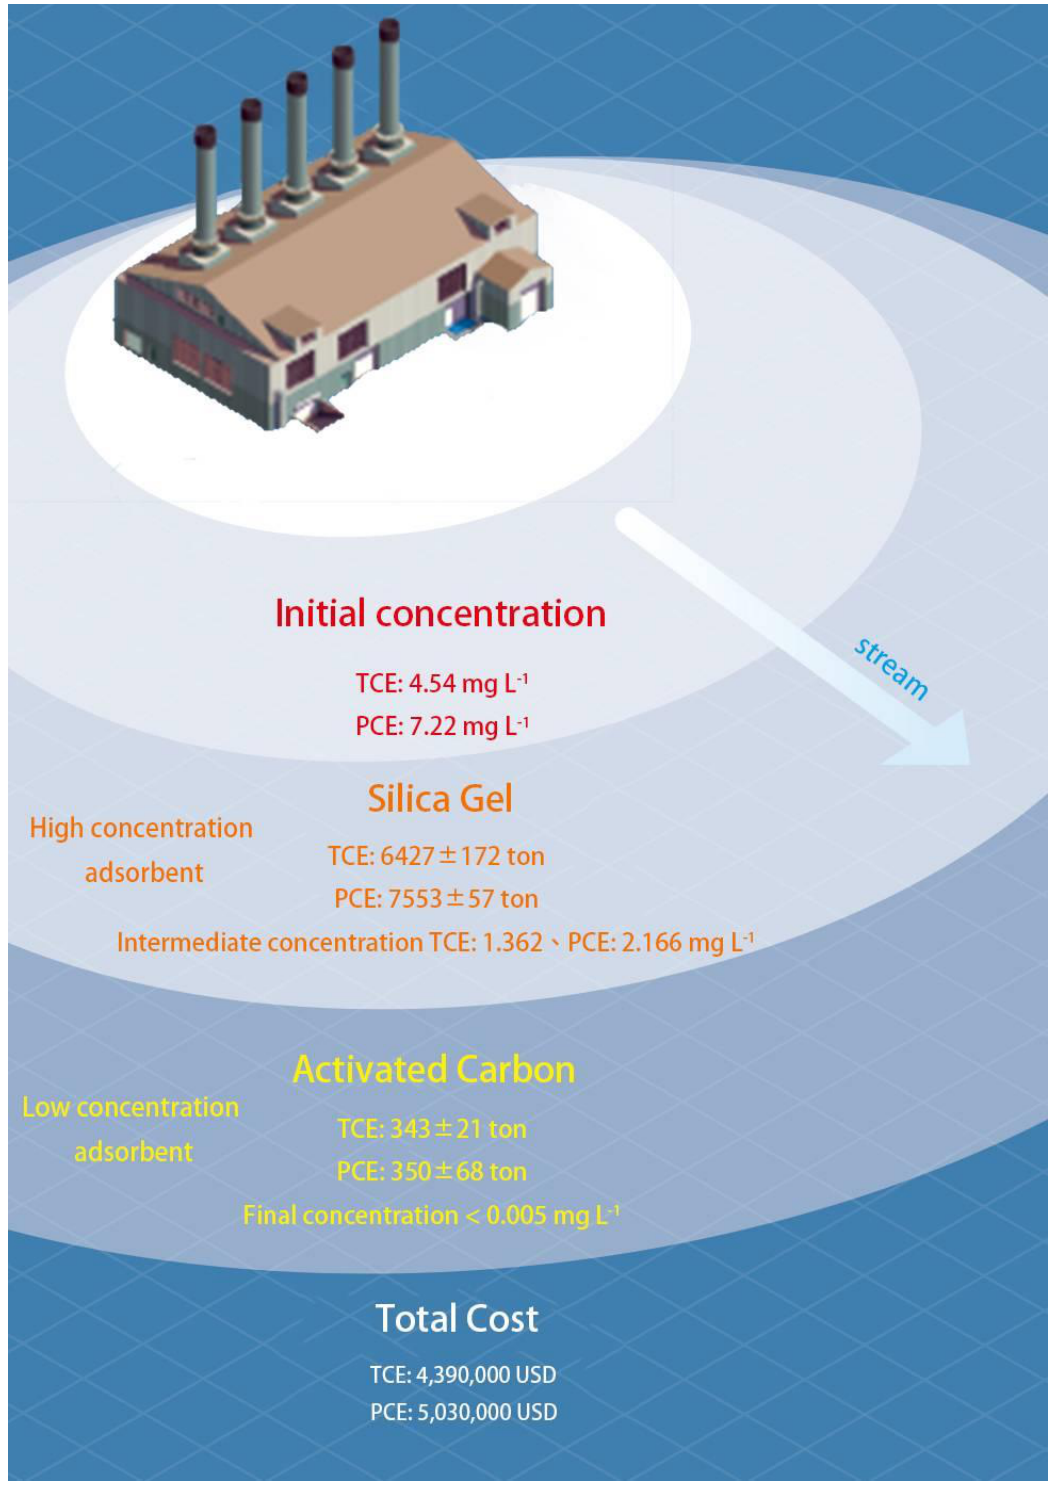
Figure 8. Predicting the adsorbent masses and amounts of silica gel and activated carbon needed for in situ remediation. (RCA, Taiwan). in situ remediation. (RCA,